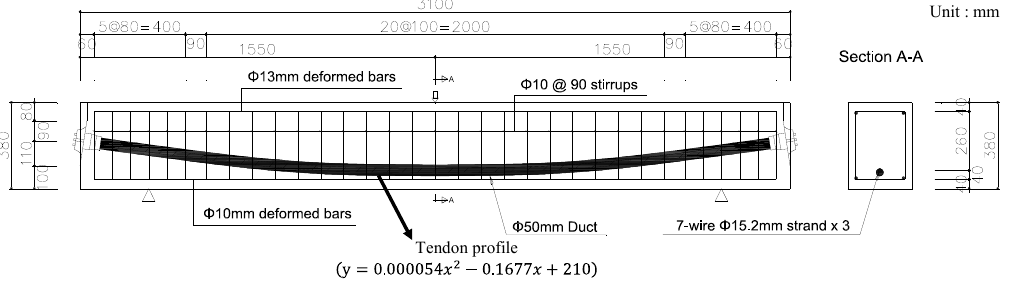
Figure 1. Detailed drawing of the prestressed concrete (PC) beam specimens.